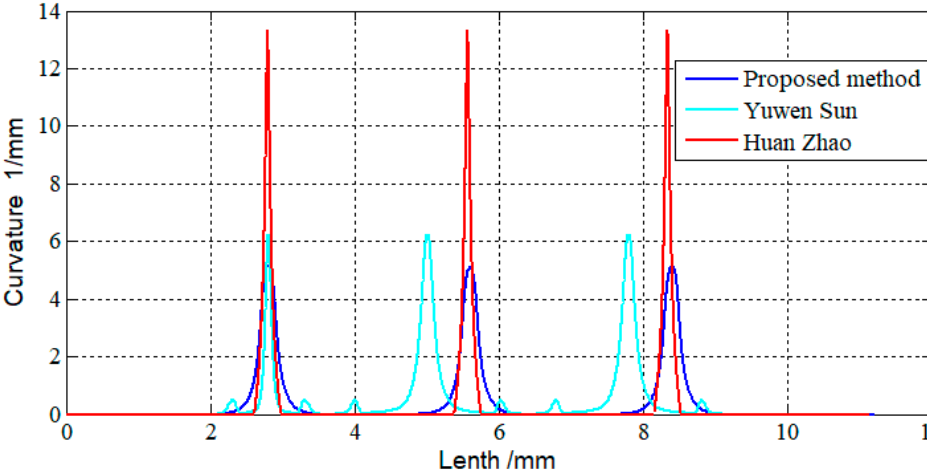
Figure 4. Curvature profiles of 2D tool path.